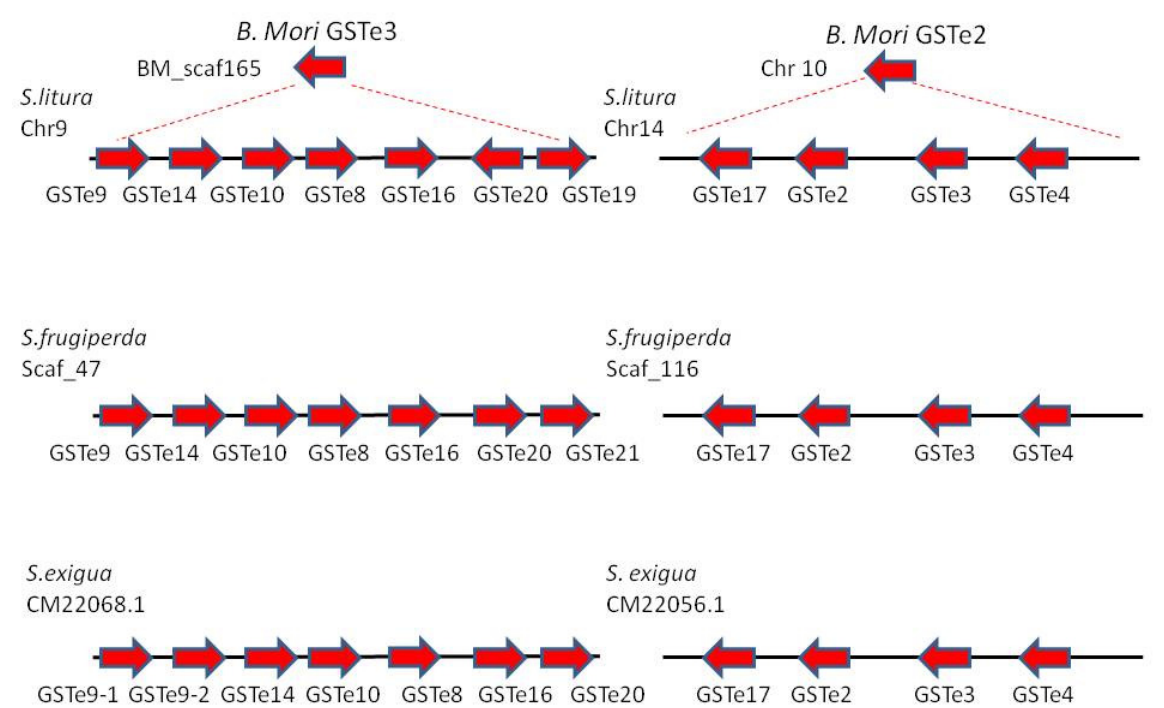
Figure 7. GSTe clusters derived from B. mori GSTe2 and GSTe3 identified in the genomes of S. litura, S. frugiperda corn and rice strains and S. exigua (adapted from [1]).